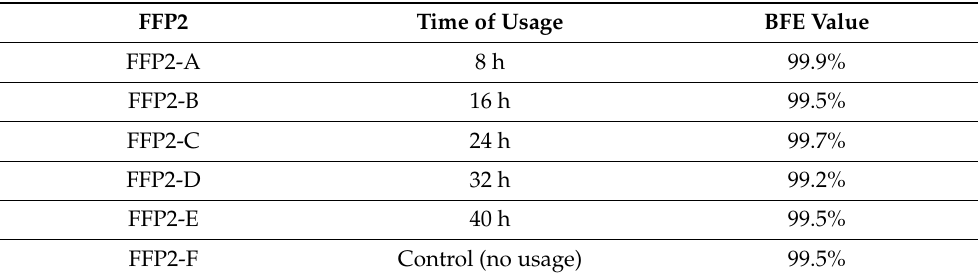
Table 1. Bacterial filtration efficacy (BFE) values of the six tested FFP2. FFP2 Time of Usage BFE Value FFP2-A 8 h 99.9% FFP2-B FFP2-C 99.7% FFP2-D 32 h 99.2% FFP2-E FFP2-F Control (no